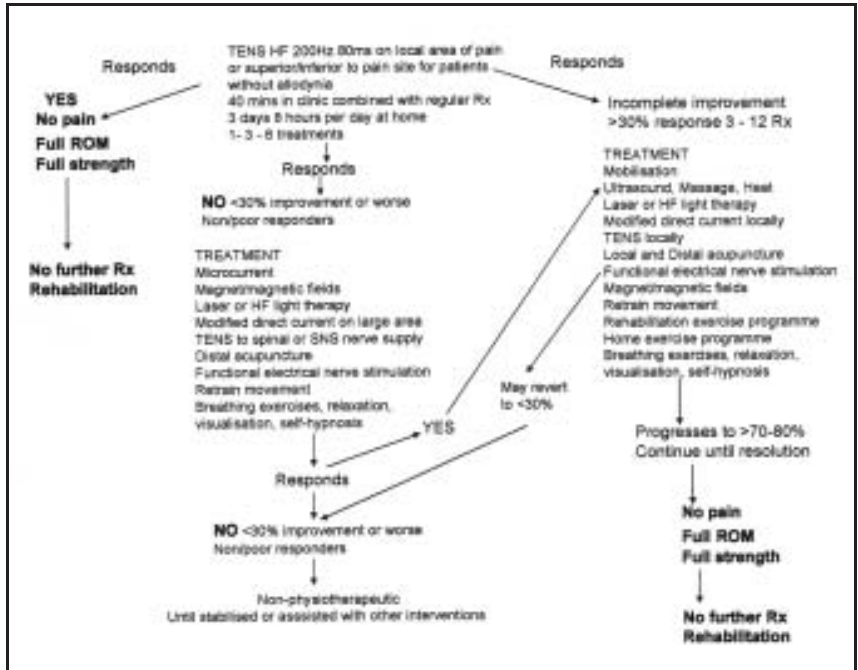
Diagram: Algorithm for the use of electrical and physical modalities in chronic back